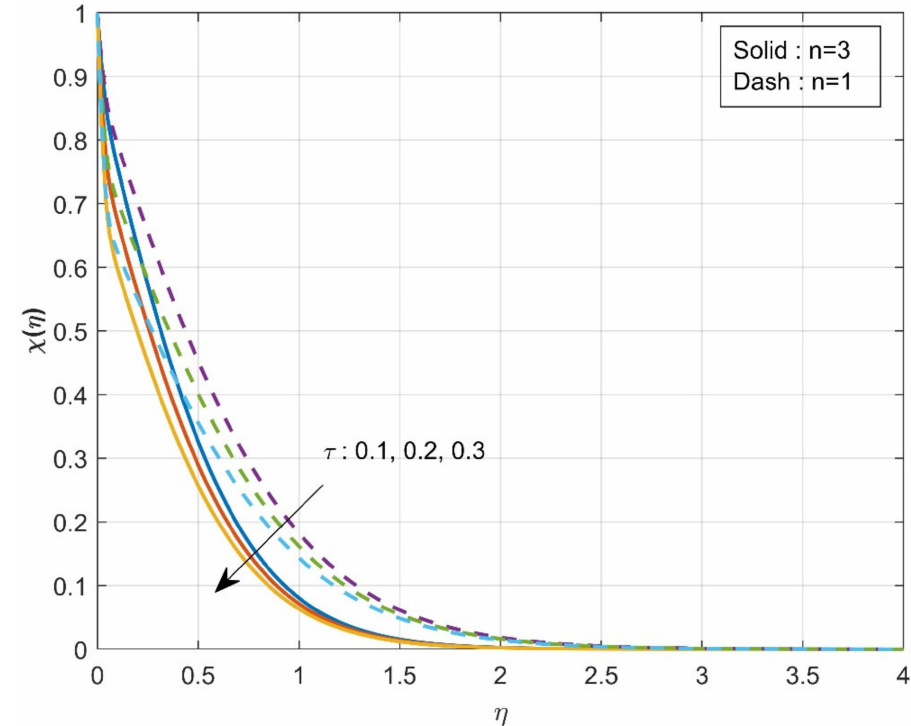
Figure 6. Influence of τ over concentration χ ( η ) .